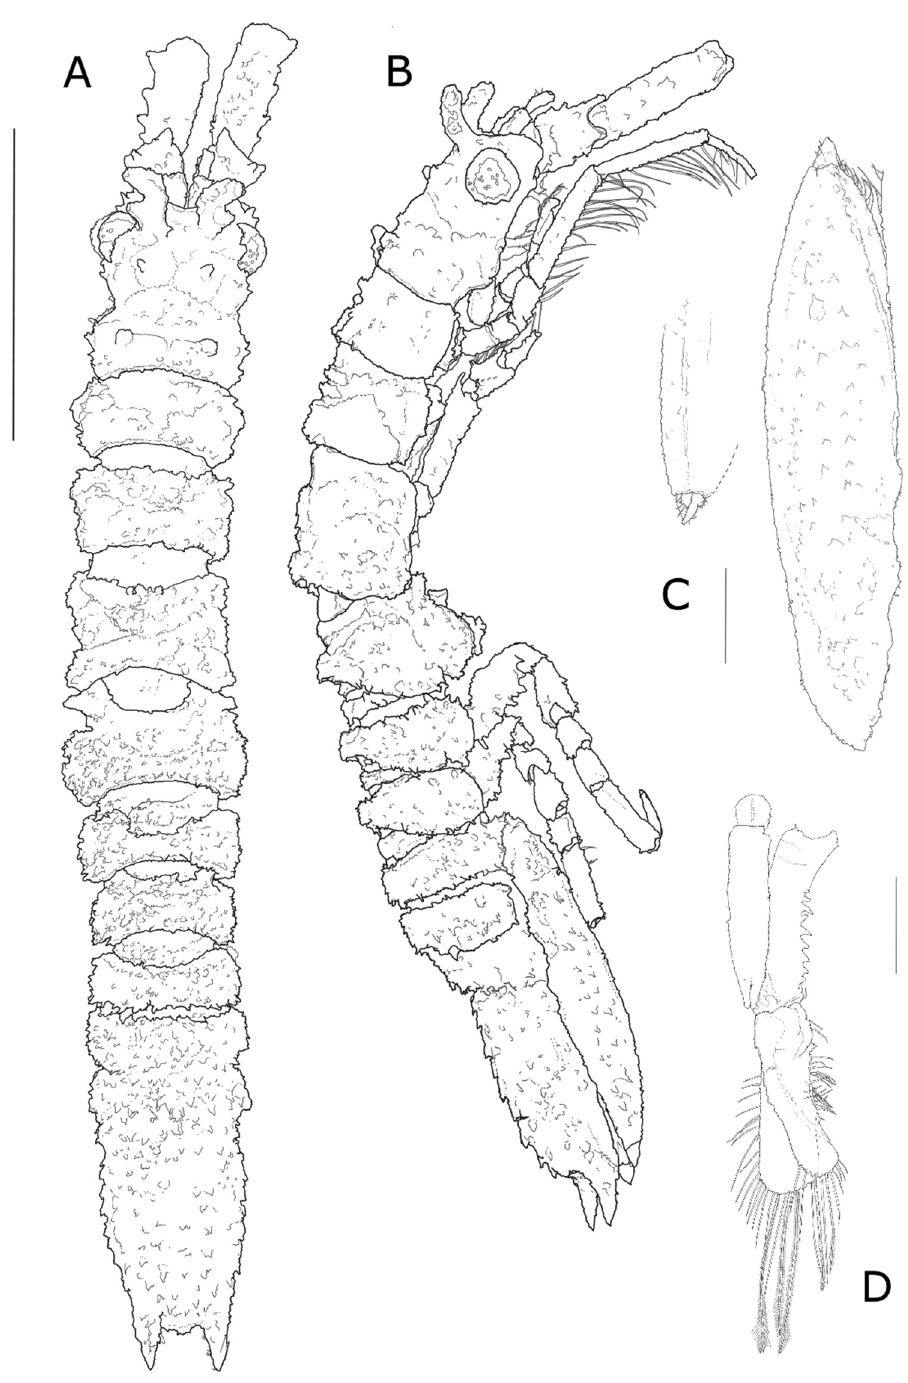
Figure 4. Chaetarcturus cervicornis sp. n. male holotype (MNA 10739) ( A ) dorsal view, scale bar = 5 mm ( B ) lateral view, scale bar = 5 mm ( C ) right uropod, scale bar = 1 mm ( D ) penis and left first pleopod, scale bar = 1 mm.